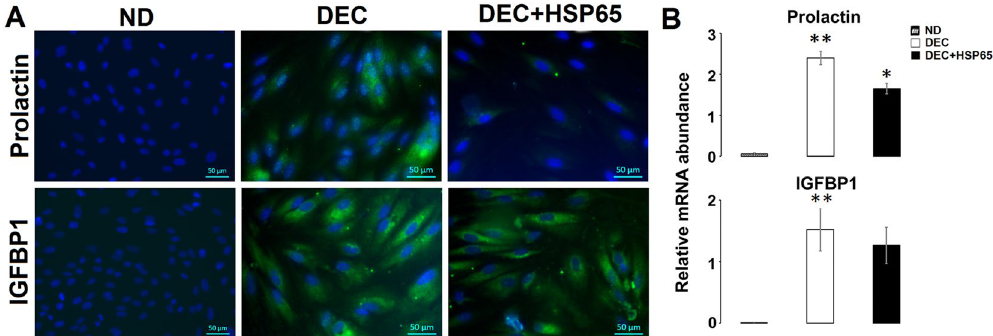
Figure 1. HSP65 alters prolactin mediated endometrial stromal cells (hESC) decidualization. Protein ( A ) and mRNA ( B ) levels of prolactin and IGFBP1, decidualization markers, in non-decidualized hESC (ND), decidualized hESC (DEC) and HSP65-treated decidualized hESC (DEC + HSP65). ND shows no expression of decidualization markers. A significant down regulation in the expression of prolactin in HSP65 treated decidualized cells. Data are represented as Mean ± SEM. * P < 0.05, ** P <